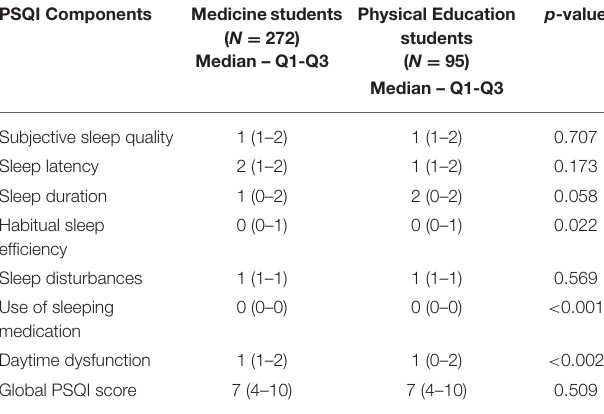
TABLE 2 | Comparison between Medicine and Physical Education students regarding the sleep variable Pittsburgh Sleep Quality